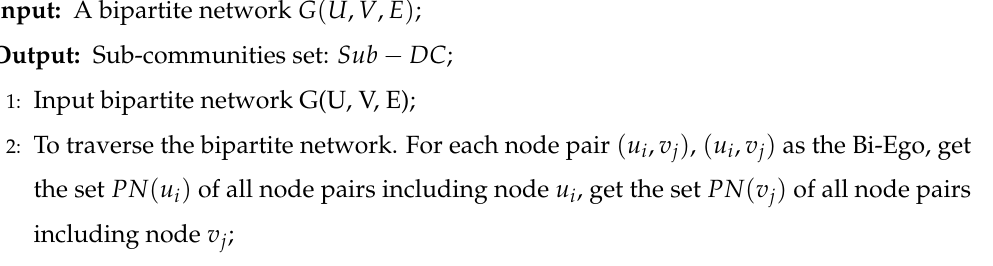
Algorithm 1 Construct Sub-communities For Node